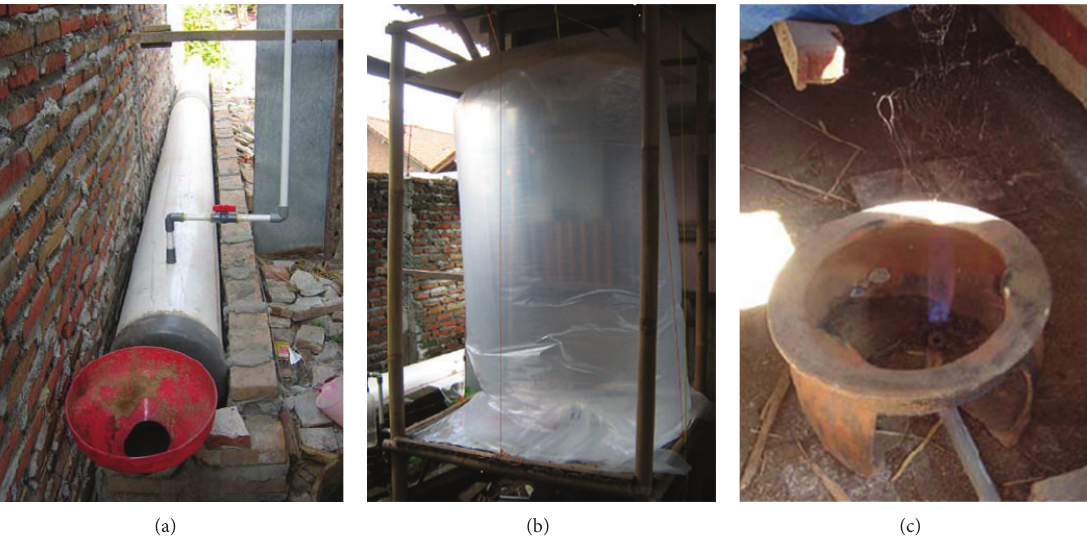
Figure 1: Field-scale Indonesian model digester. Pictures of a typical household biogas system: (a) the PVC digester, (b) the biogas collection bag, and (c) a traditional household cook stove fueled with biogas from the household